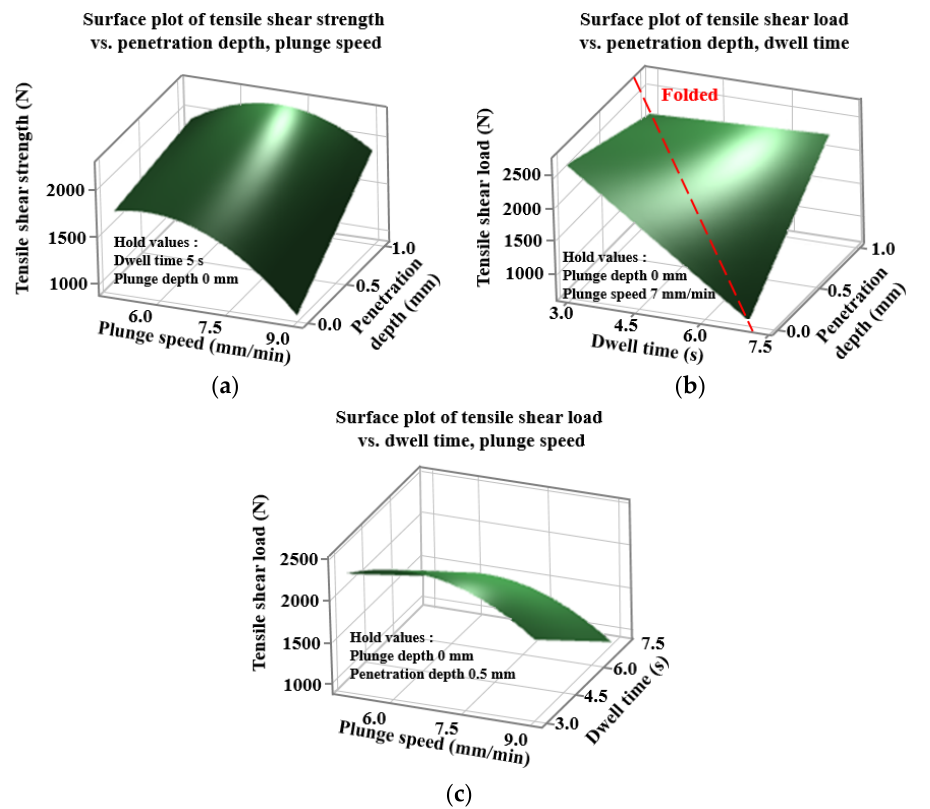
Figure 6. Surface plots of tensile shear load. ( a ) Penetration depth and plunge speed; ( b ) penetration depth and dwell time; ( c ) dwell time and plunge